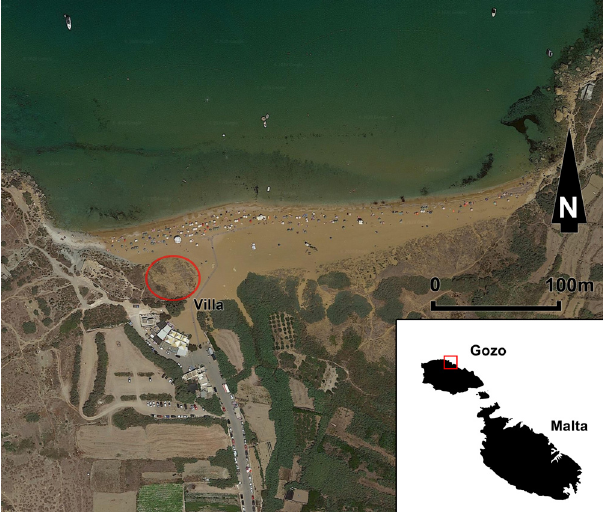
Figure 1: Showing location of Villa remains at Ramla l - Ħ amra Bay, Gozo. Archaeological remains circled in red ( Source: Google Earth )